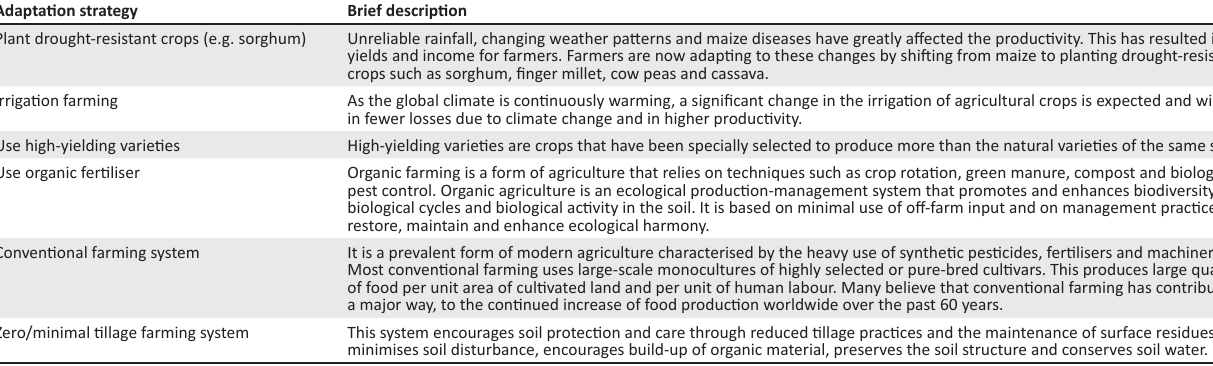
TABLE 5: Adaptation strategies perceived as important in Lambani and Alice. Adaptation strategy Brief description